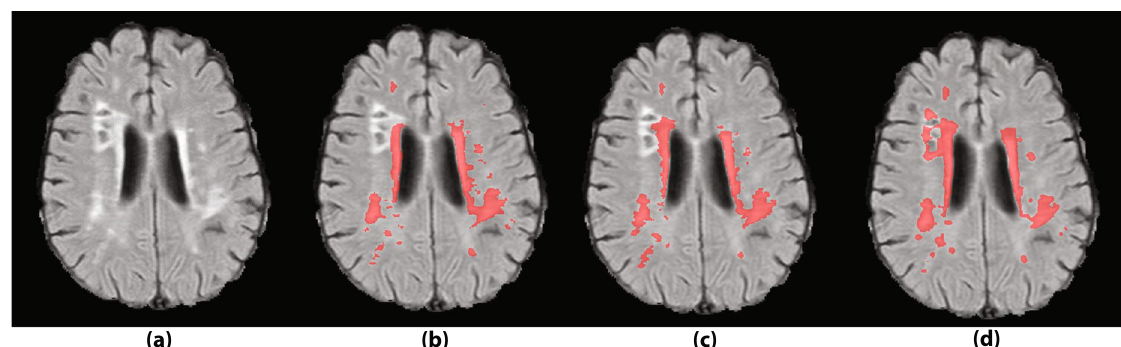
Figure 7. Gliosis around the lacunes is a prevalent type of false positive segmentation. ( a ) FLAIR images without annotations. ( b ) Segmentation by human observer 1. ( c ) Segmentation by human observer 2. ( d ) Segmentation by MSWS + Loc